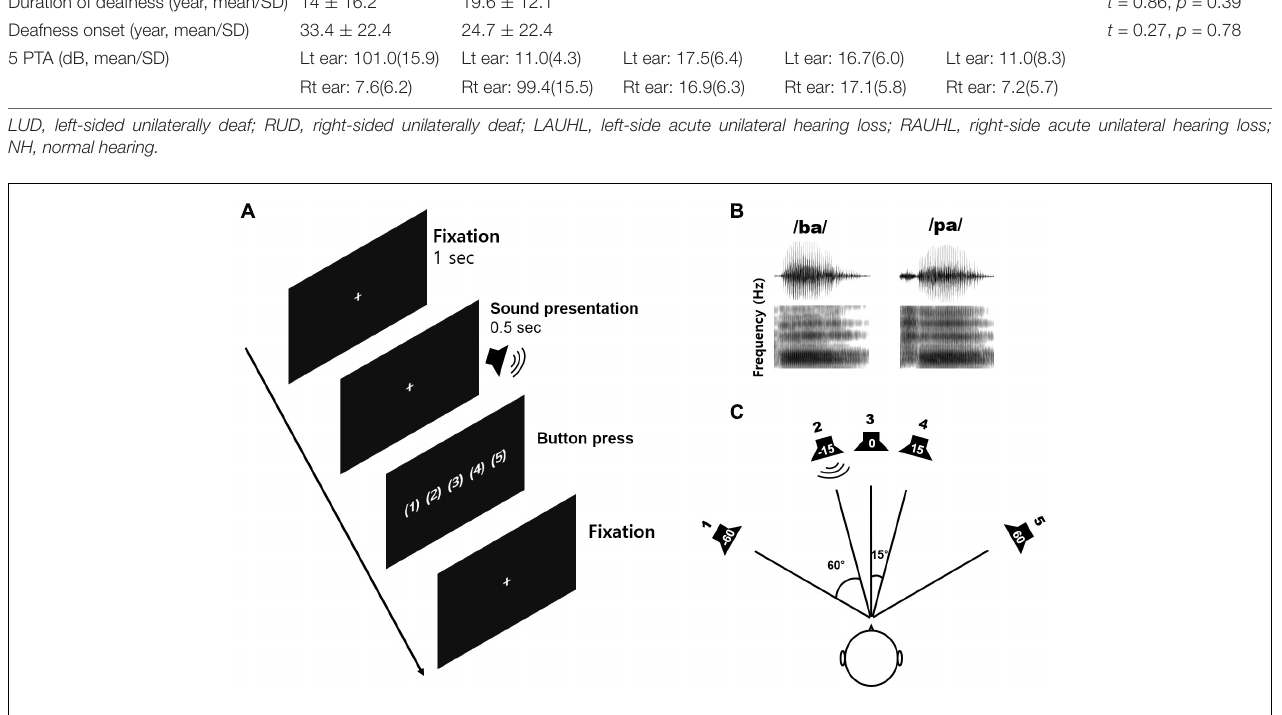
FIGURE 1 | The sound localization paradigm and acoustic stimuli used in the study. (A) An example of the acoustic sequence for the active listening conditions. (B) The speech stimuli comprising/ba/and/pa/played for a duration of 0.5 s with varied inter-stimulus intervals. A new trial was started after the subject had performed a button press. (C) The sound localization paradigm including five different azimuth angles (–60 ◦ , –15 ◦ , 0 ◦ , +15 ◦ , and +60 ◦